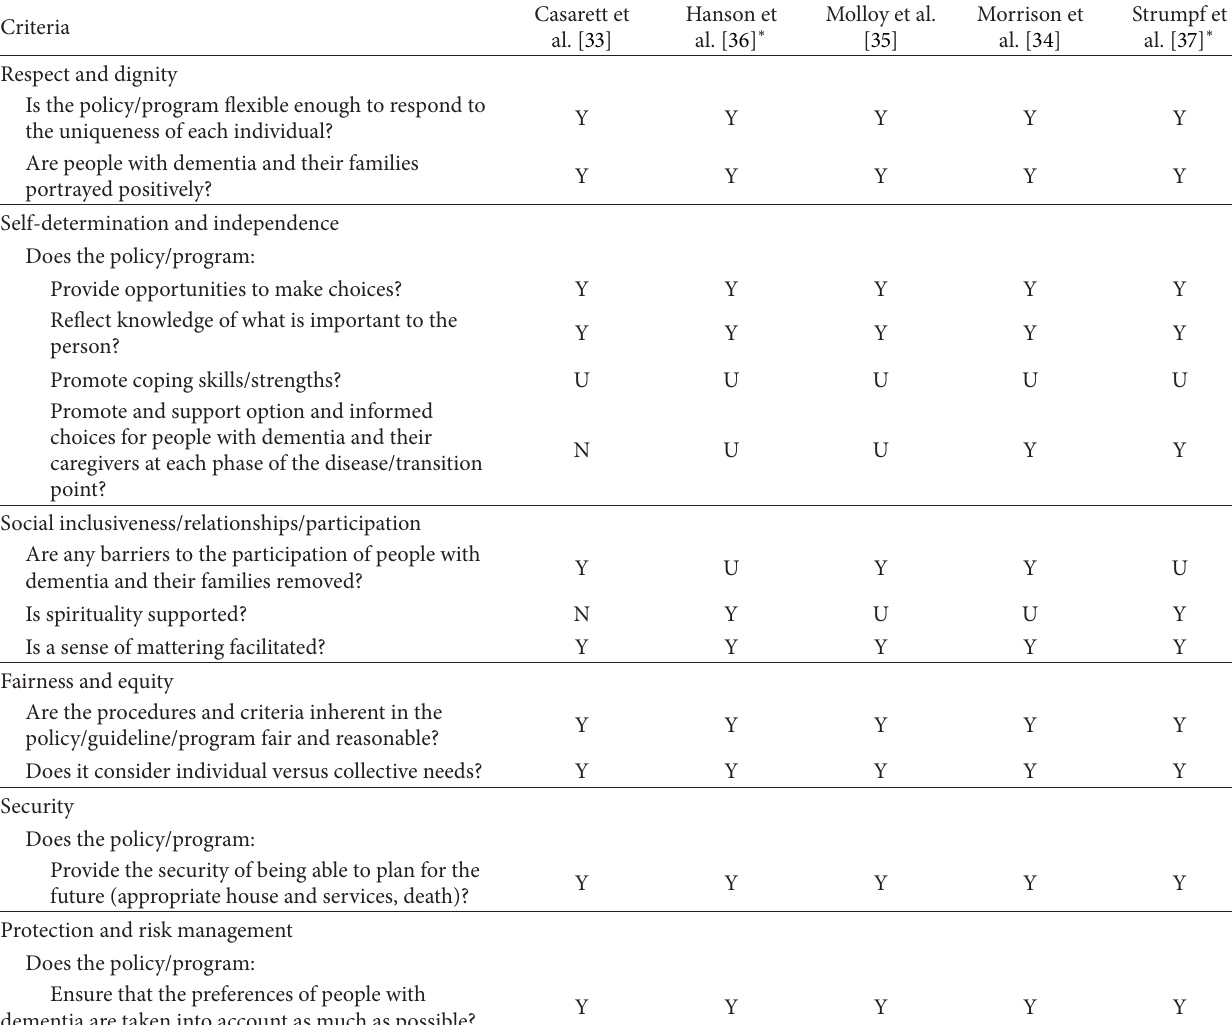
Table 4: Evaluation of advance care planning programs using the sixth criterion of the Dementia Policy Lens Toolkit.